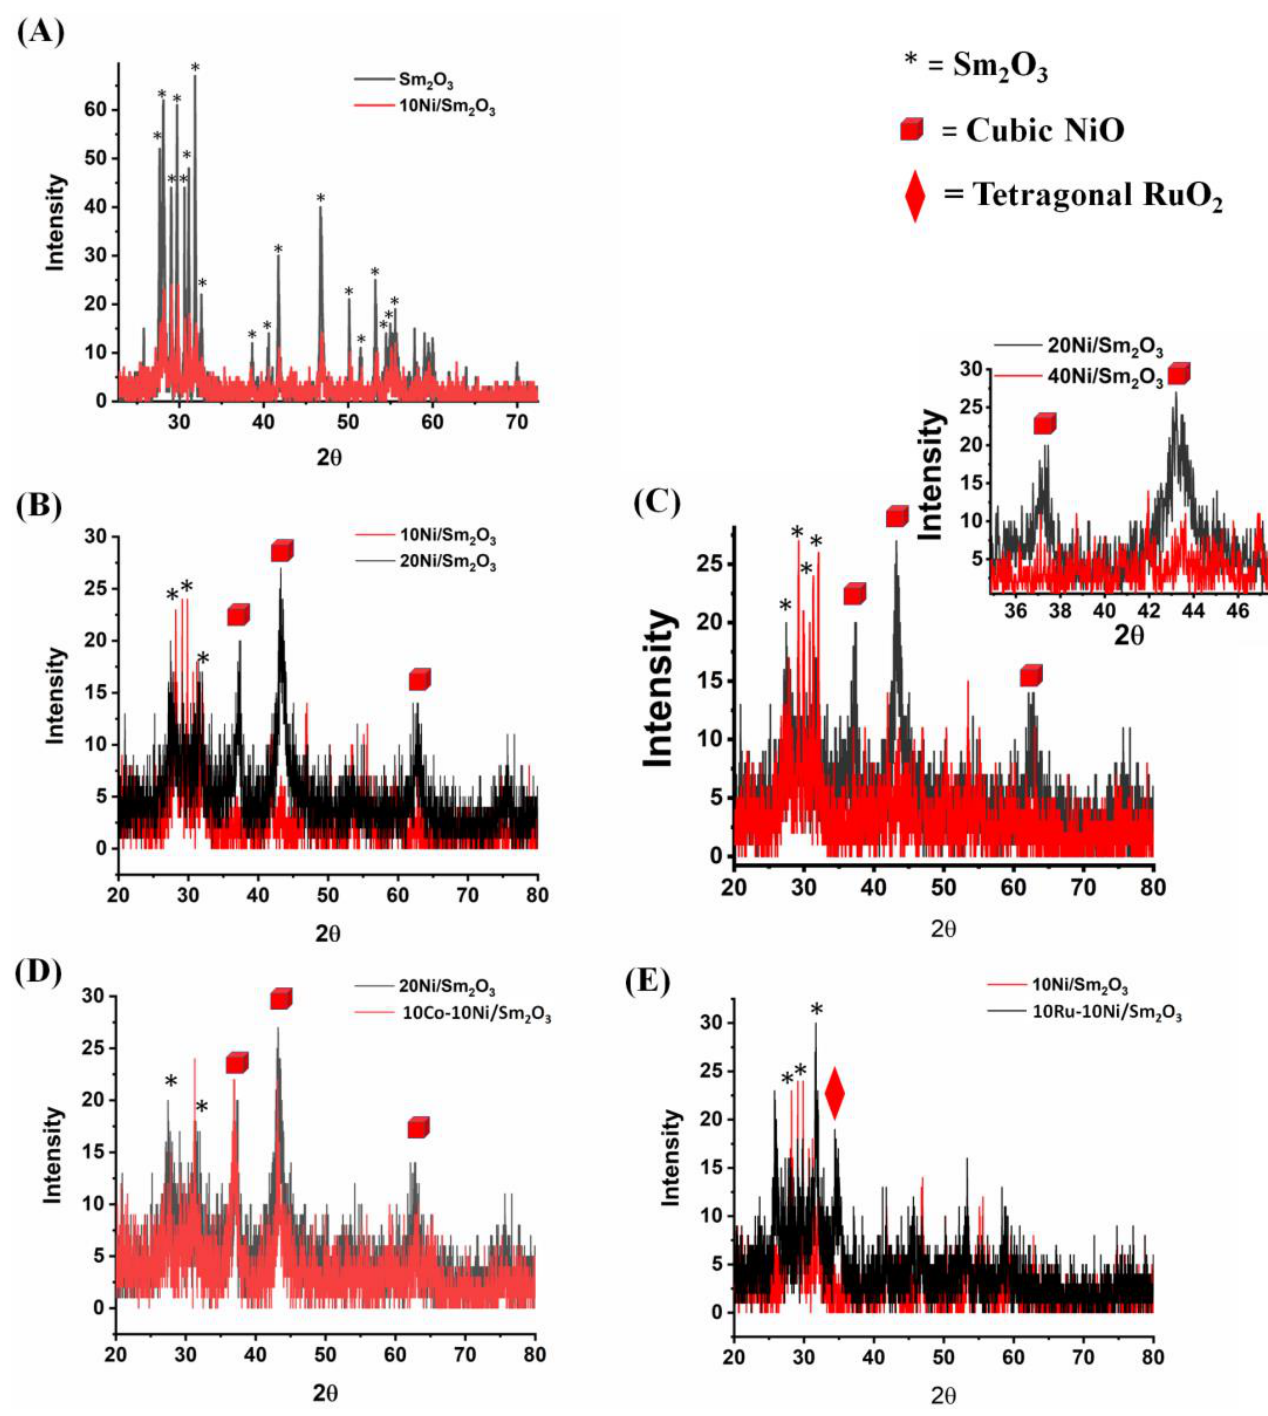
Figure 2. X-ray diffraction profiles of ( A ) Sm 2 O 3 and 10Ni/Sm 2 O 3 ( B ) 10Ni/Sm 2 O 3 and 20Ni/Sm 2 O